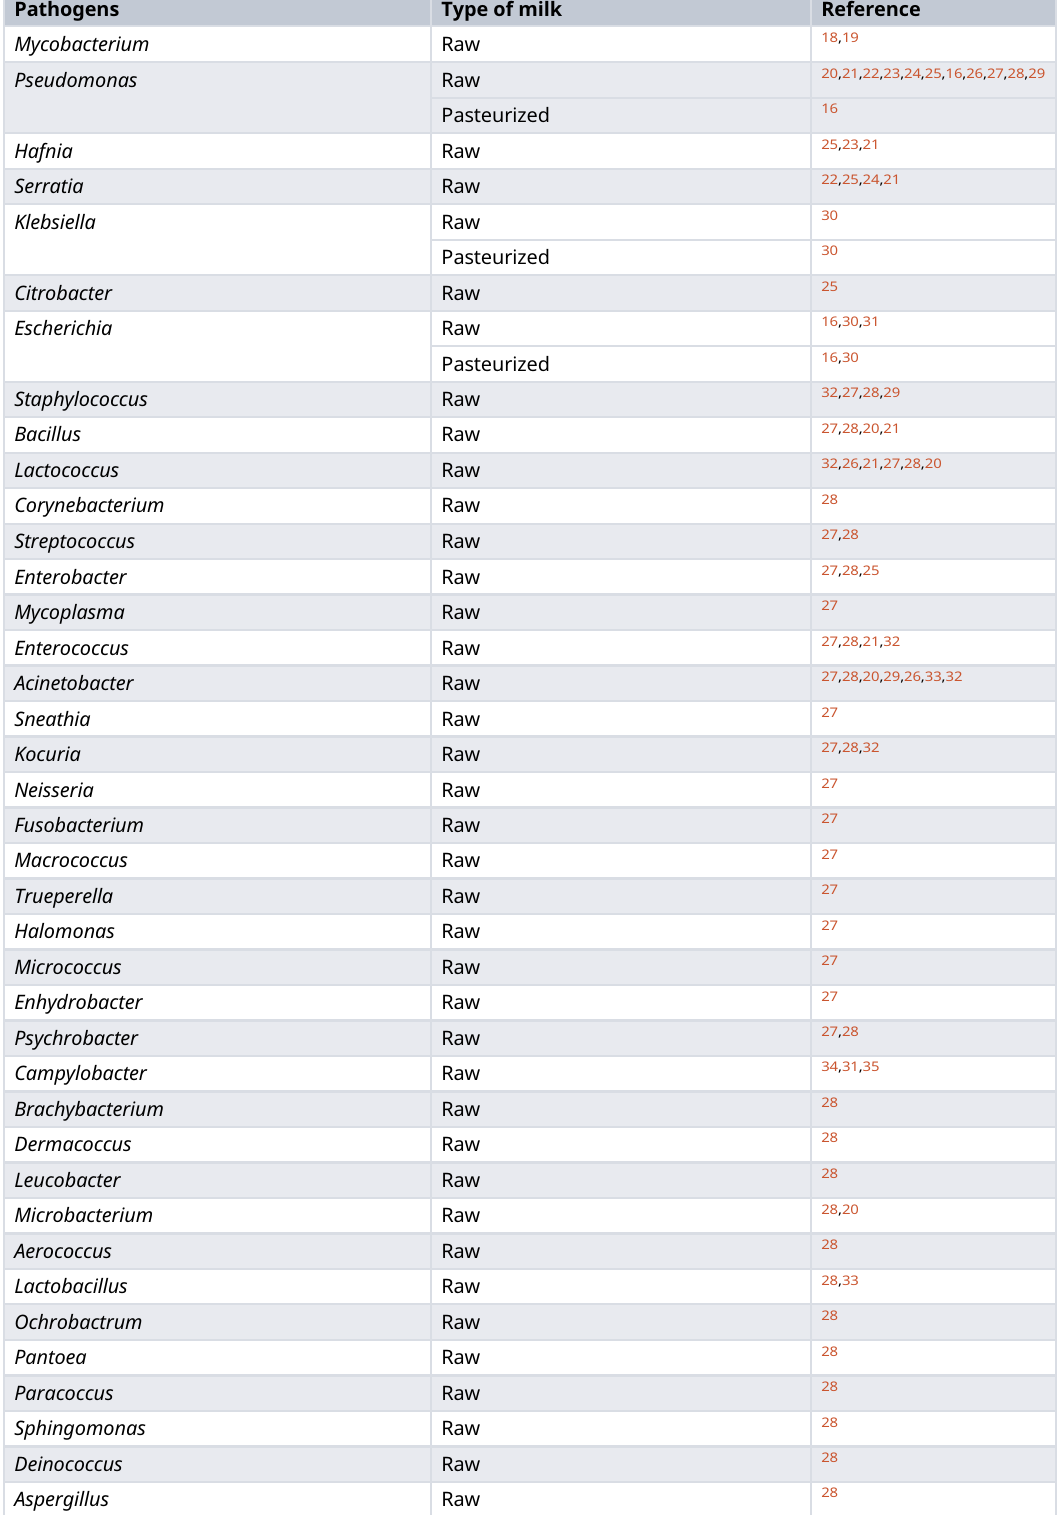
Table 1. Pathogens in bovine milk reported in literature.